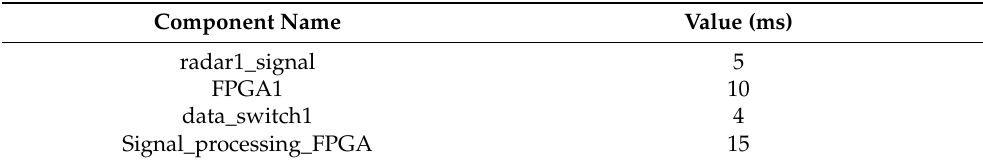
Table 1. The delay time of hardware components in the task